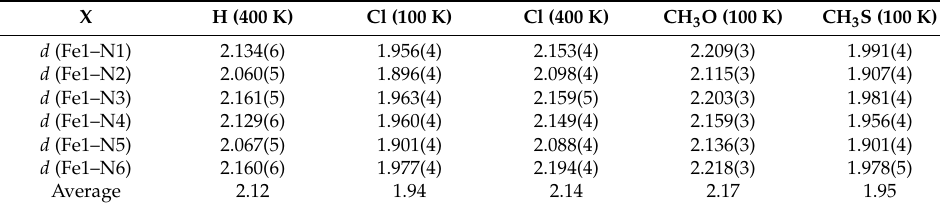
Table 2. Fe–N bond distances ( d ) in Å for [Fe(X-pybox) 2 ](ClO 4 ) 2 (X = H, Cl, CH 3 O, CH 3 S).